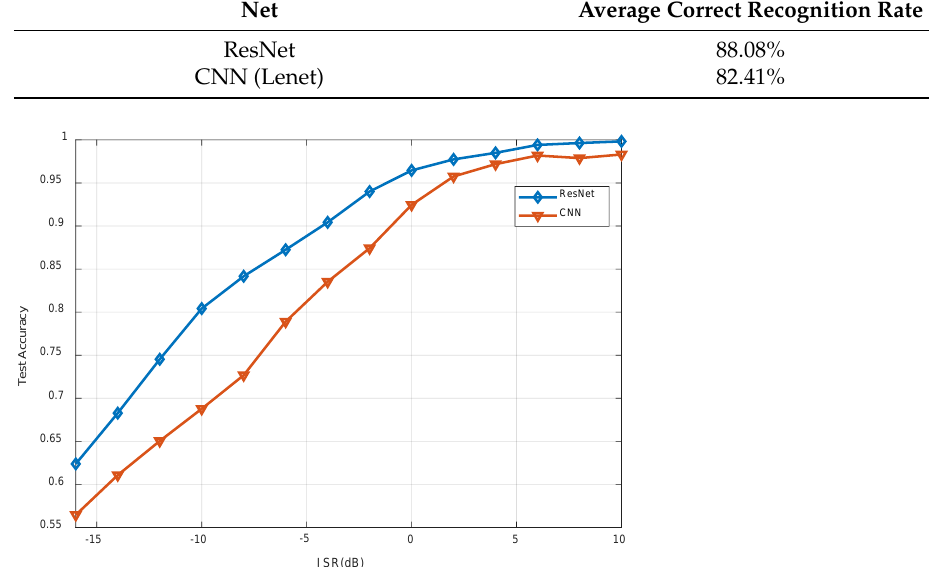
Table 6. Performance comparison of ResNet and CNN under single-node method.